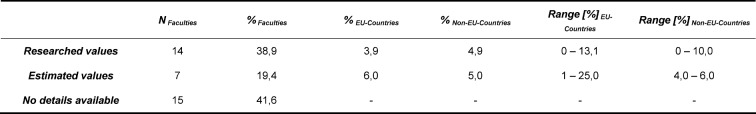
Descriptive representation of data of the proportion of international medical students, differentiated according to EU and non-EU immigrant background; Data in n= absolute number, %- share and range of percentages